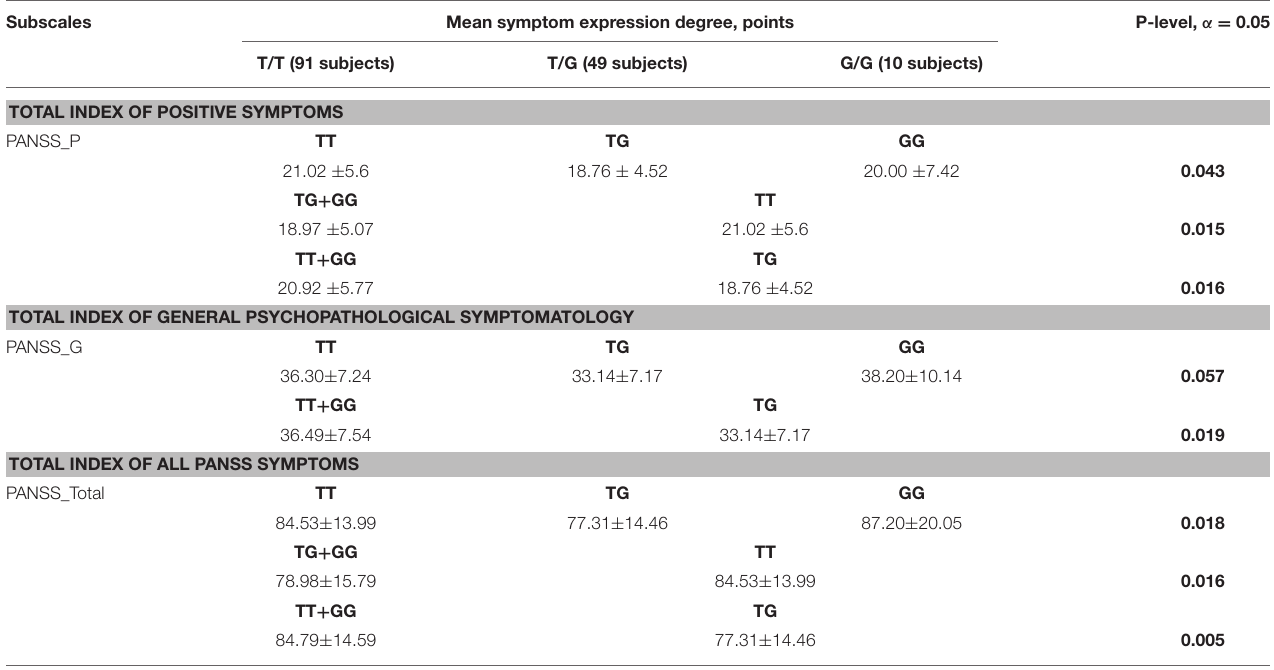
TABLE 6 | Significant association of MIR137 rs1625579 polymorphism with symptom expression degree according to PANSS in schizophrenia patients. Subscales